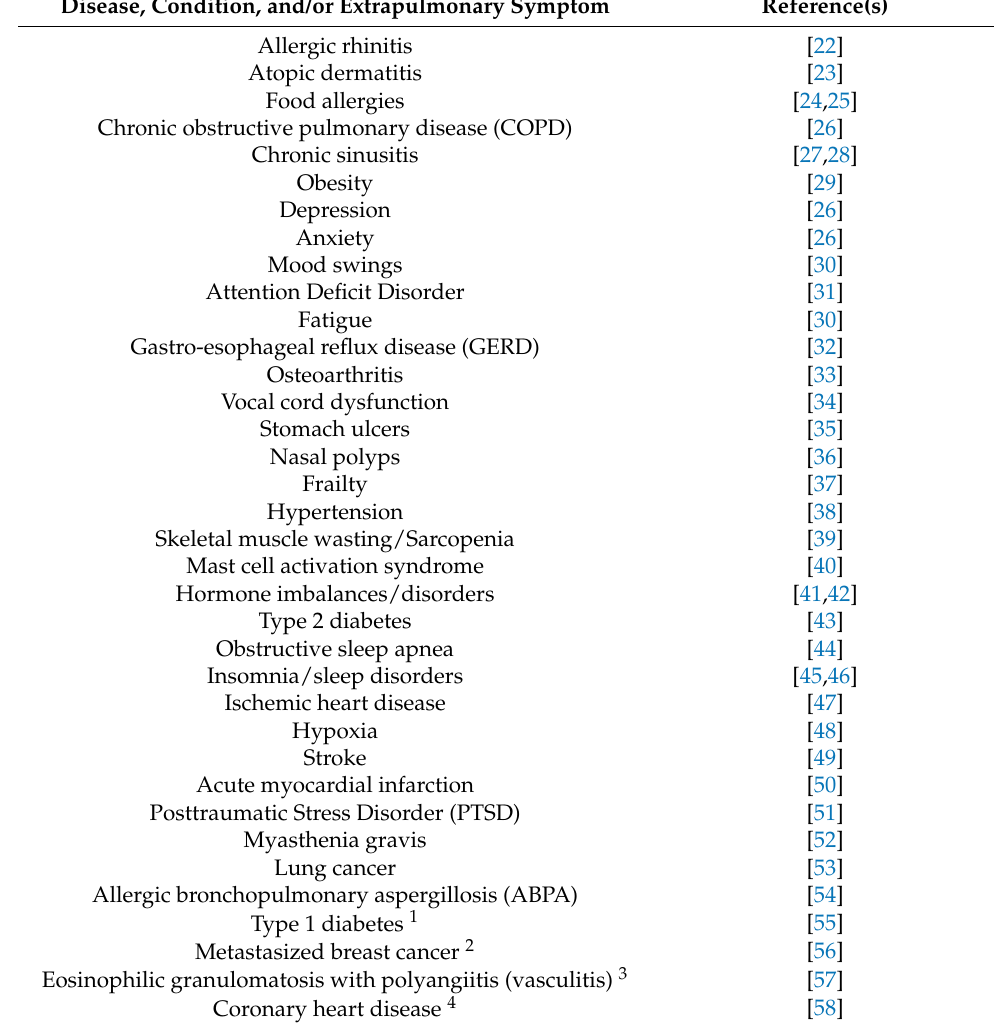
Table 1. Comorbidities of